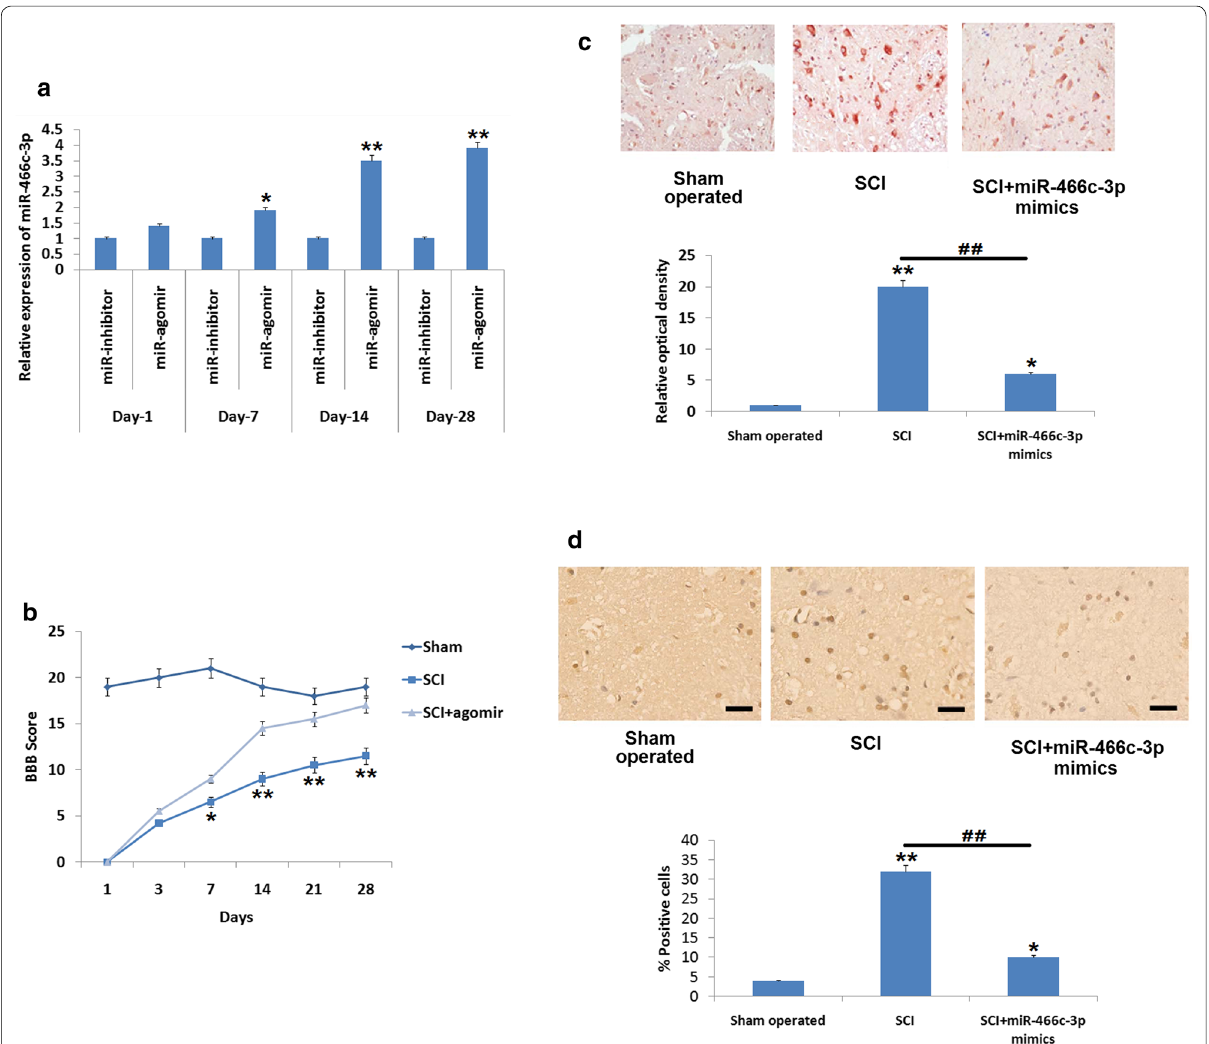
Fig. 2 a Expression of miR-466c-3p was determined by qRT-PCR reaction on the 1st, 7th, 14th and the 28th day after inducing spinal cord injury followed by treatment of miR-466c-3p mimics. *P < 0.05, **P < 0.01 compared to respective miR-inhibitor negative control. b Outcomes of BBB analysis for evaluation of locomotor activity on the 1st, 7th, 14th and the 28th day after inducing spinal cord injury after treating the animals with miR-466c-3p agomir. c Results of Immunohistochemical analysis showing expression of cleaved caspase-3 in the spinal tissue after spinal cord injury. *P < 0.05, **P < 0.01 compared to sham operated animals; ##P < 0.01 compared to SCI rats. d Results of TUNEL assay for studying the